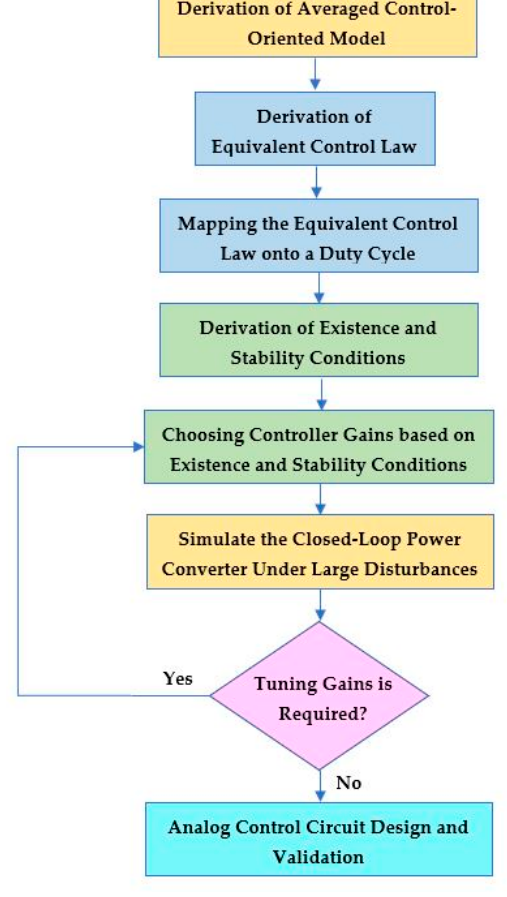
Figure 5. Development of proposed control circuit of PWM DC-DC Cuk converter.